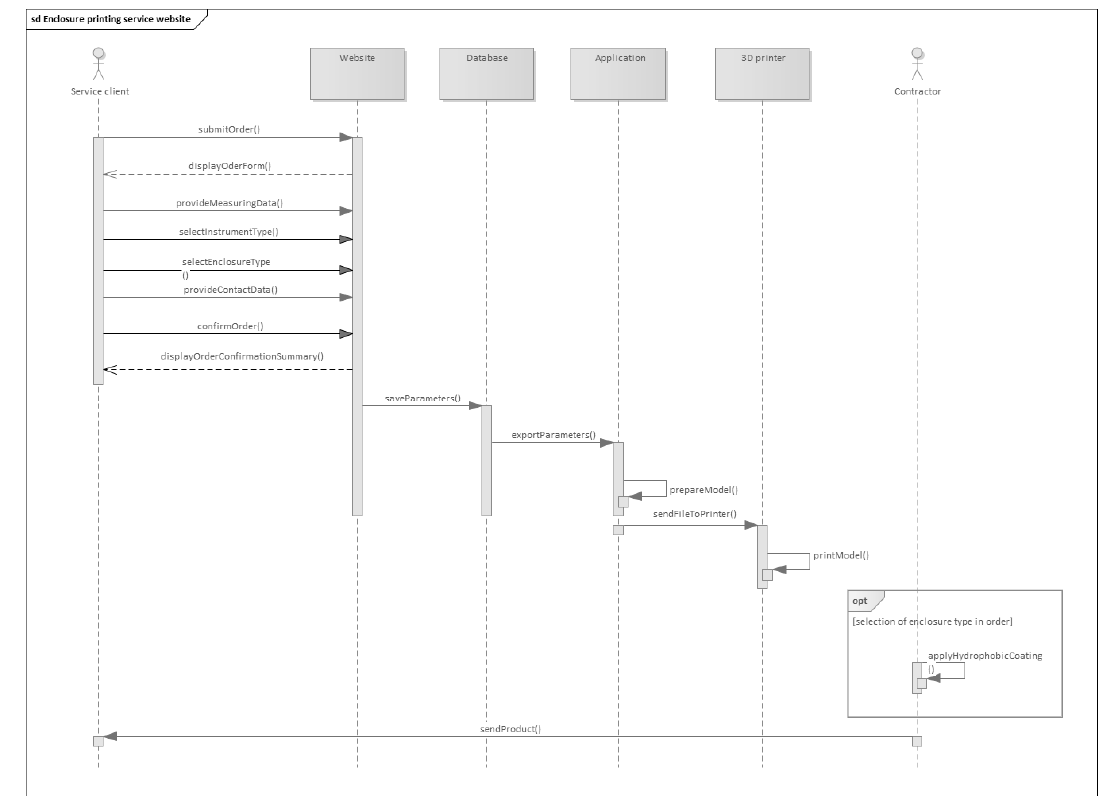
Figure 8. UML diagram formalizing the enclosure printing website.